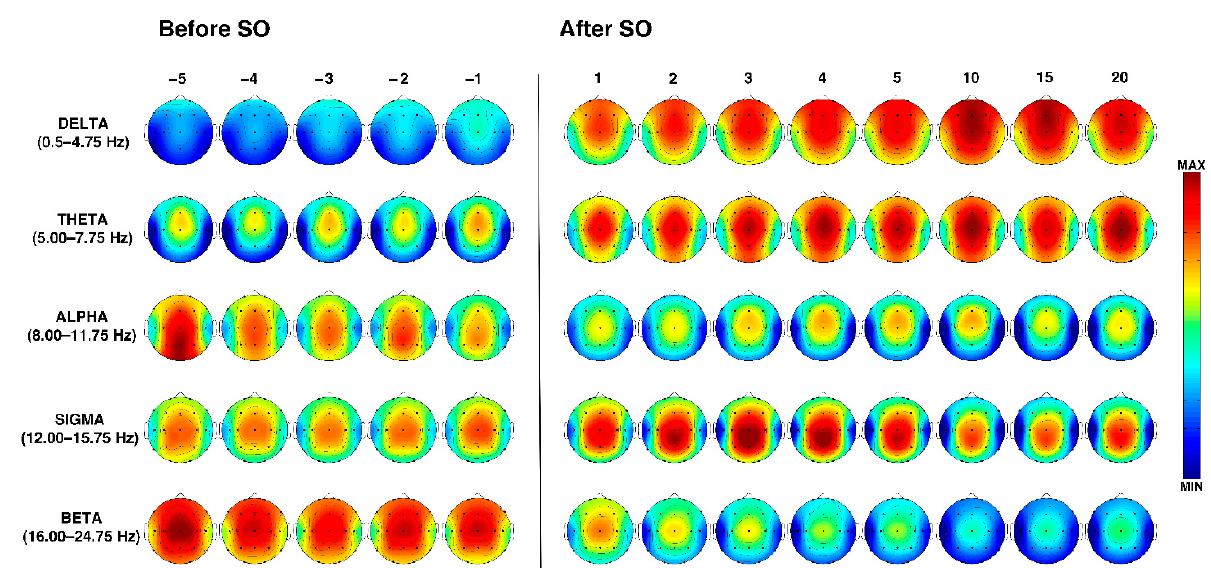
Figure 2. Time course of EEG frequency bands during the SO process in older adults. From the left, topographic EEG shows changes across the interval preceding SO, that is, from the lights off to the first epoch of stage 2 NREM sleep. The power maps were obtained by subdividing the pre-SO interval into five equal parts (from the –5th to –1st). Data were calculated for each subject and then averaged across subjects. After the vertical line, indicating the first epoch of stage 2 sleep, the first five intervals after SO (from the 1st to the 5th) are plotted. The last three columns on the right side show power maps at the 10th, 15th, and 20th time intervals calculated across the first sleep cycle. Values are color-coded and plotted at the corresponding position on the planar projection of the scalp surface and are interpolated (biharmonic spline) between electrodes. The maps are based on the 19 unipolar EEG derivations of the international 10–20 system with averaged mastoid reference. Maps are plotted for the following EEG bands: delta (0.50–4.75 Hz), theta (5.00–7.75 Hz), alpha (8.00–11.75 Hz),